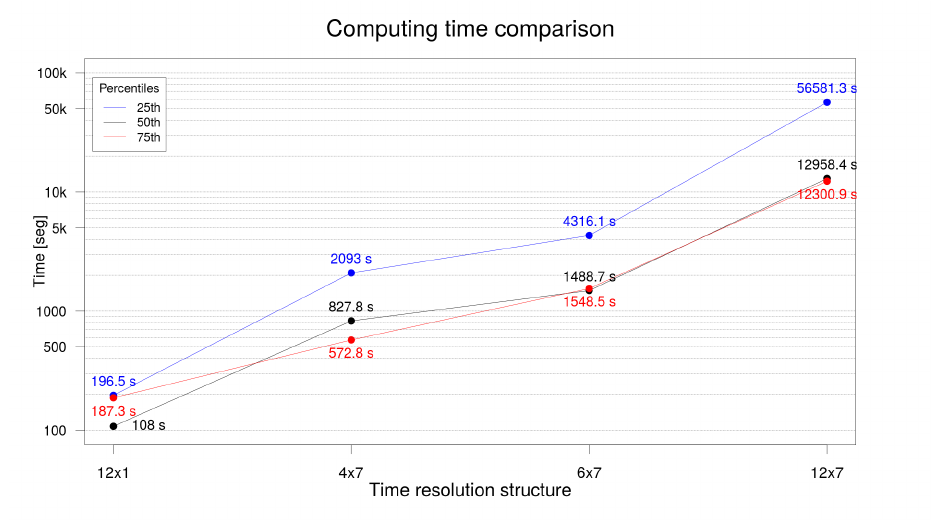
Figure 11. Computing time comparison for different time resolution